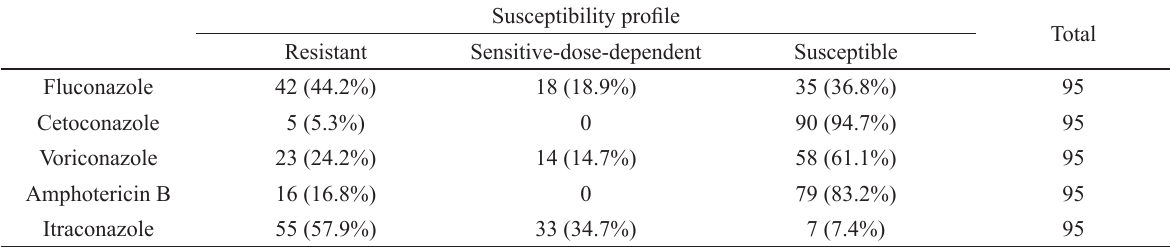
Number of isolates showing each susceptibility profile for each of the five antifungals tested in the minimum inhibitory concentration